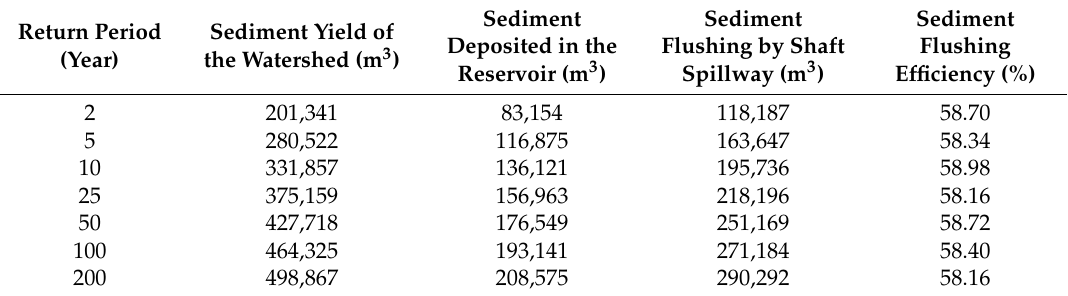
Table 1. Empty flushing efficiency in one-day storms under different return periods.